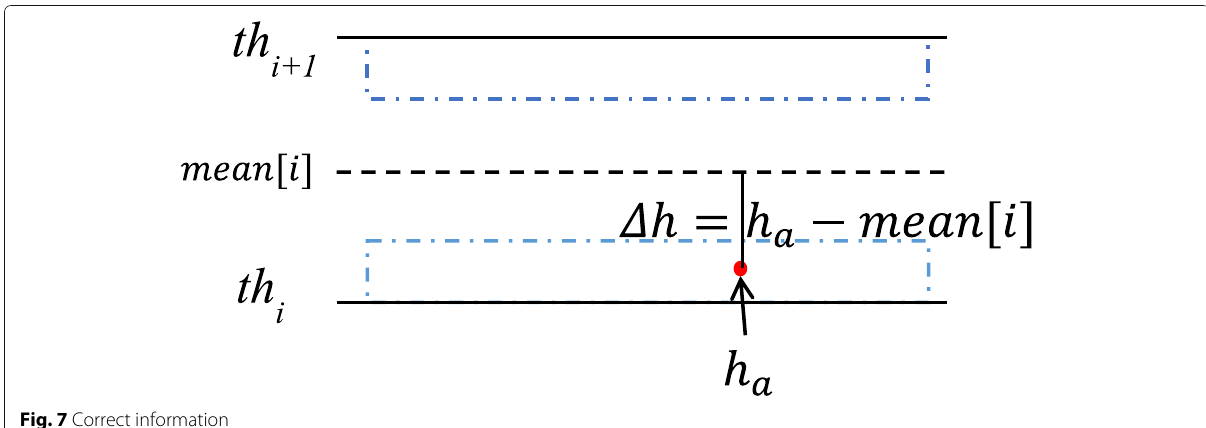
4.4 Randomness extractor and privacy amplification After information reconciliation, Alice and Bob get the same initial key, but some of the bits might be exposed to the attacker. And when the channel changes slowly or even in a static environment, a large number of consecutive measurements will fall in the same inter-